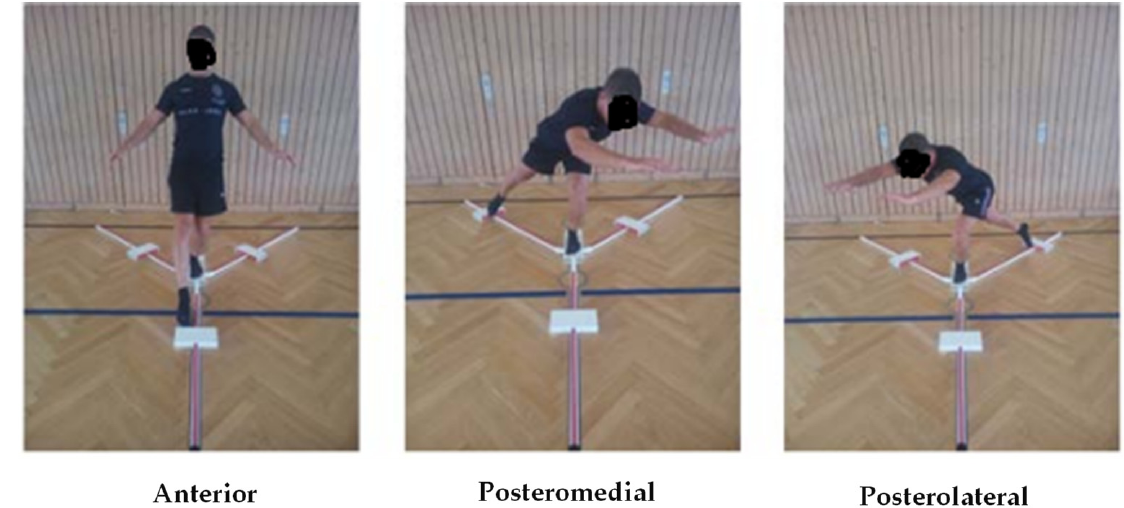
Figure 1. The Y-Balance